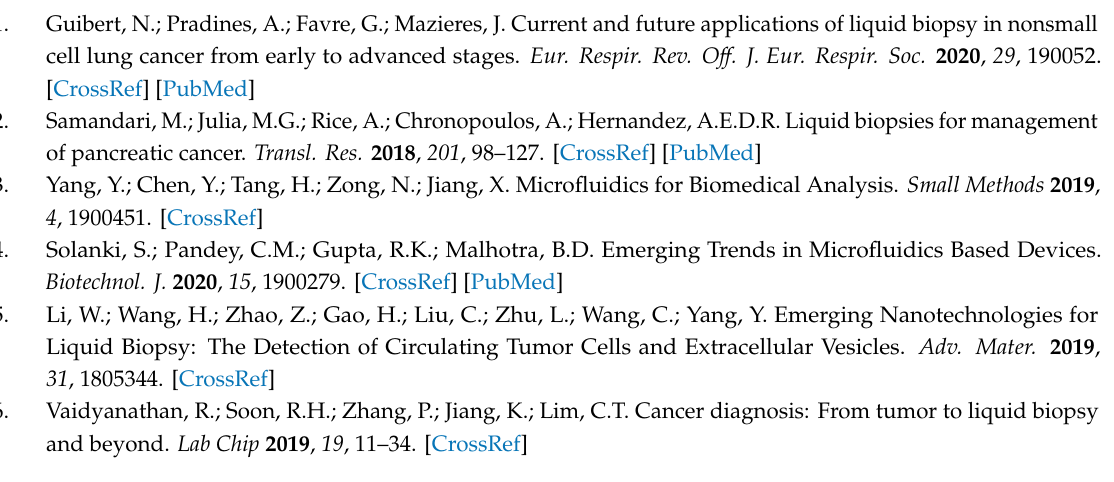
Figure S1: PCR assay to test PDMS compatibility; Figure S2: optimization of silanization time; Figure S3: fluorescent microRNAs adsorption on